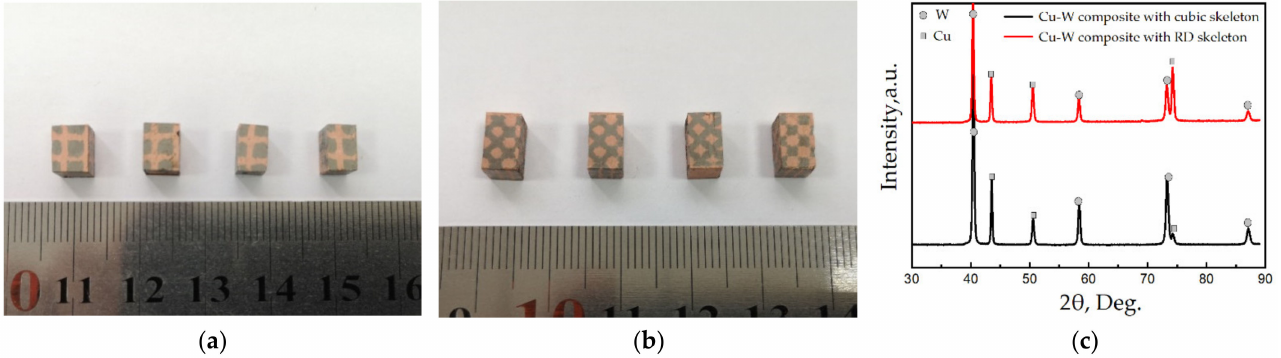
Figure 2. Macroscopic images of the studied Cu-W composite with cubic ( a ) and rhombic dodecahe- dron (RD) ( b ) W-skeleton, and their XRD profiles ( c